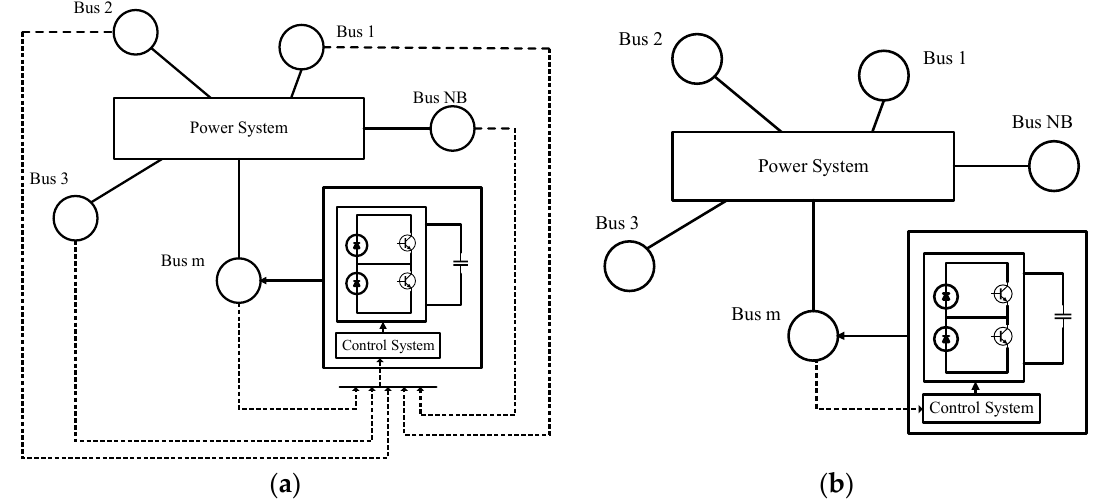
Figure 2. Network data structure in the presence of an APF with ( a ) integrated control system and ( b ) stand-alone control system.